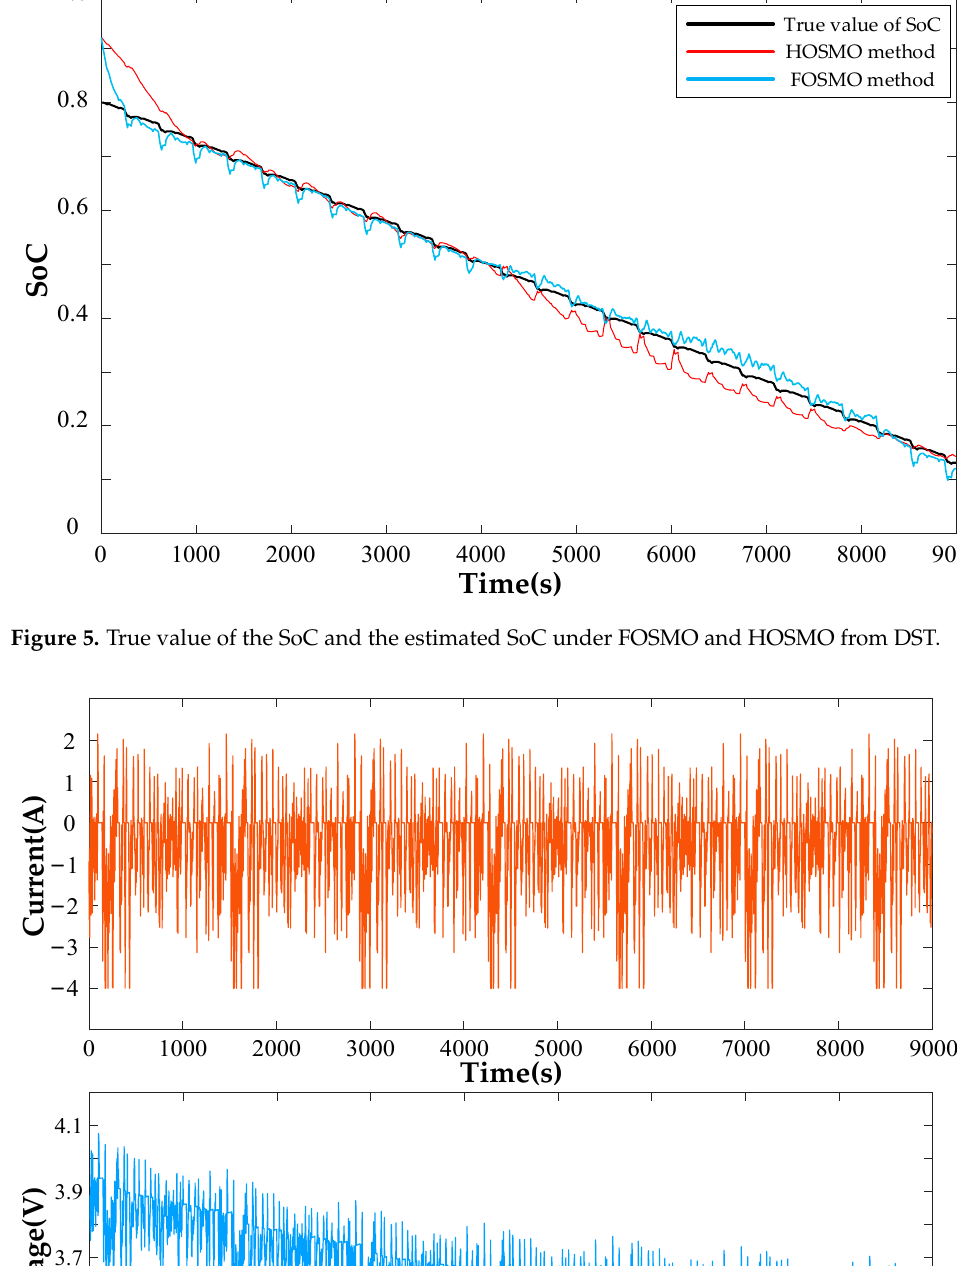
Figure 4. The current and the terminal voltage of the lithium battery from DST.